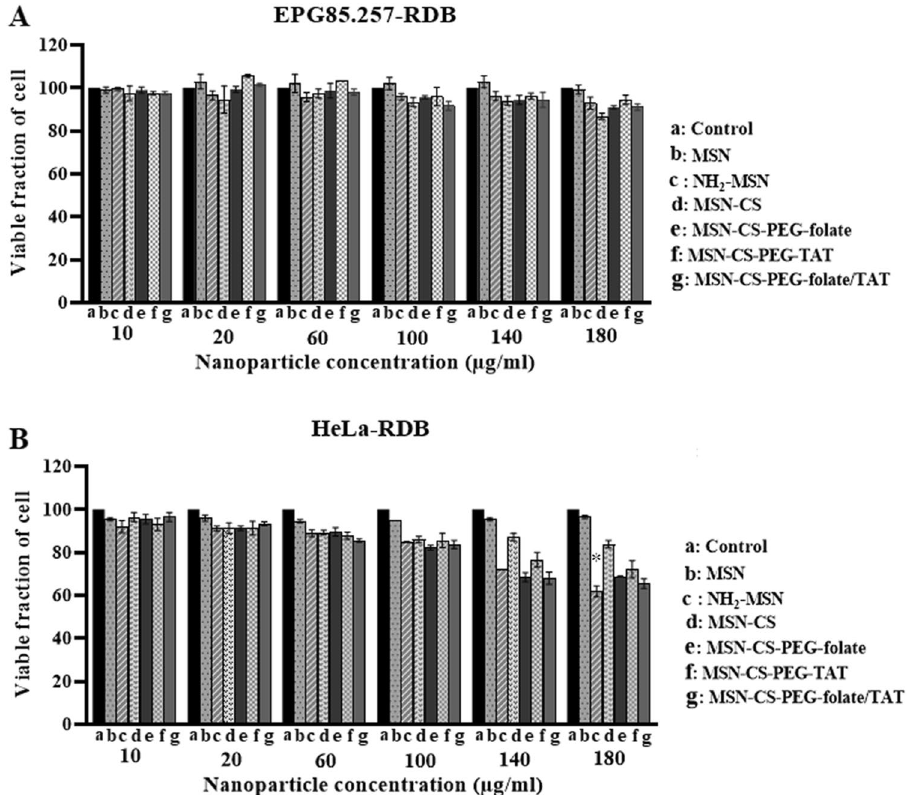
Figure 5. Cytotoxicity evaluation of the nanostructures. EPG85.257-RDB and HeLa-RDB viability after 72 h incubation with nanoparticle-free media (a), MSN (b), NH 2 -MSN(c), MSN-CS(d), MSN-CS-PEG-folate (e), MSN-CS-PEG-TAT (f), and MSN-CS-PEG-folate/TAT (g). Nanoparticles were found to be biocompatible, and the treatment concentration should not exceed 100 μg/ml. Data showed that nanoparticles were biocompatible, and the treatment concentration should not be exceeded 100 μg/ml. *p < 0.05 denote significant differences between the control and treatment samples according to the one-way ANOVA (non-parametric Kruskal–Wallis analyses). CS Chitosan, PEG polyethylene glycol, TAT trans-activator of transcription.